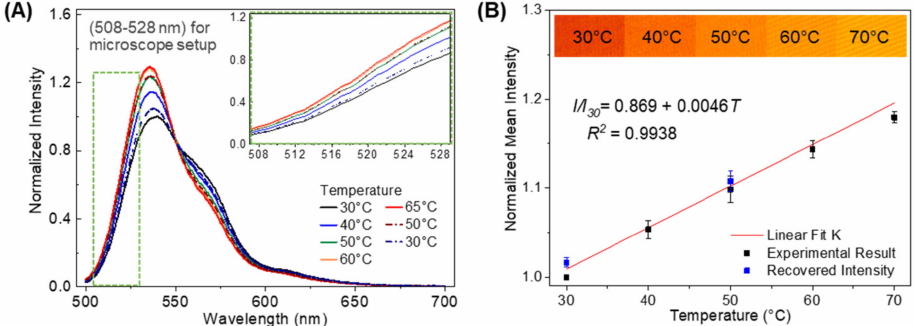
Figure 2. ( A ) Fluorescence emission spectra of rhodamine 6G (R6G) as a function of temperature measured using the microplate reader; solid lines represent spectra during heating cycle while dot-dash lines represent spectra during cooling. The green boxed region and inset are the 508–528 nm range selected for the imaging experiments. ( B ) Averaged R6G fluorescence micrograph pixel intensities as a function of temperature captured through 508–528 nm bandpass filter and normalized to the reference intensity at 30 ◦ C. Theine represents linear fit with equation and associated R 2 in plot. (Inset) False-colored fluorescence micrographs demonstrating intensity changes with increasing